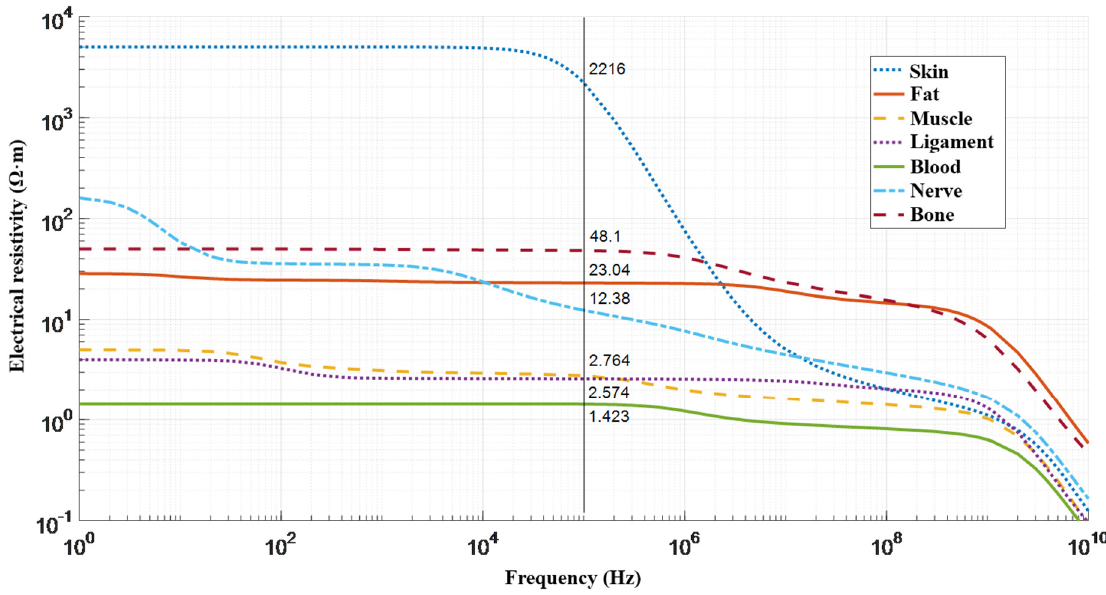
Figure 1. Resistivities for various human tissues in the region of interest as a function of frequency [43].